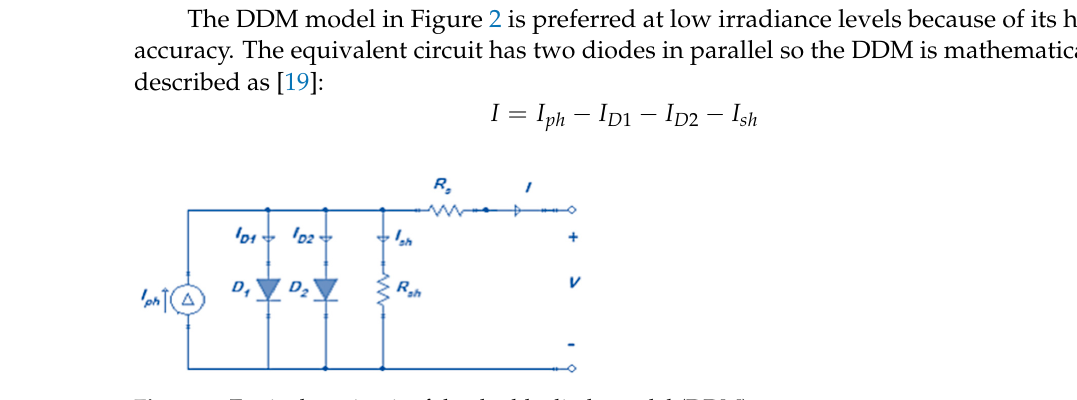
6 of 36 Figure 1. Equivalent circuit of the single diode model (SDM). 2.2. DDM The DDM model in Figure 2 is preferred at low irradiance levels because of its high